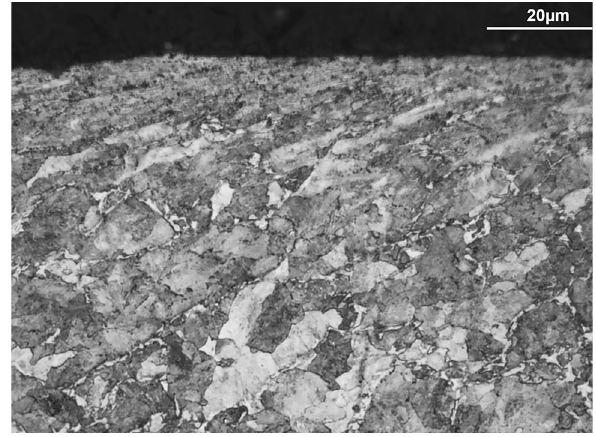
Fig. 4 Near-surface microstructure of a Class B wheel showing deformation and degradation associated with thermal loading; severely deformed pearlite was shown